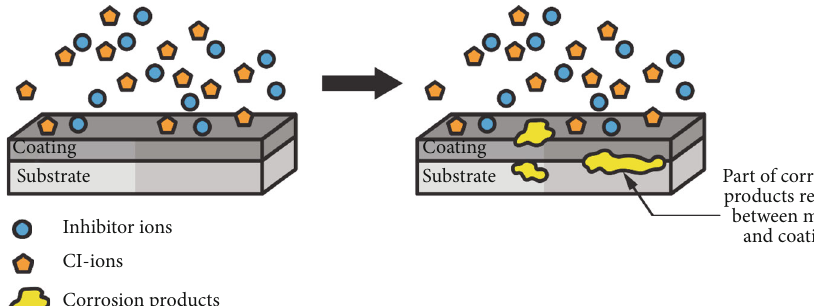
Figure 16: Proposed scheme for the formation and trapping processes of corrosion products at the substrate-coating interface.